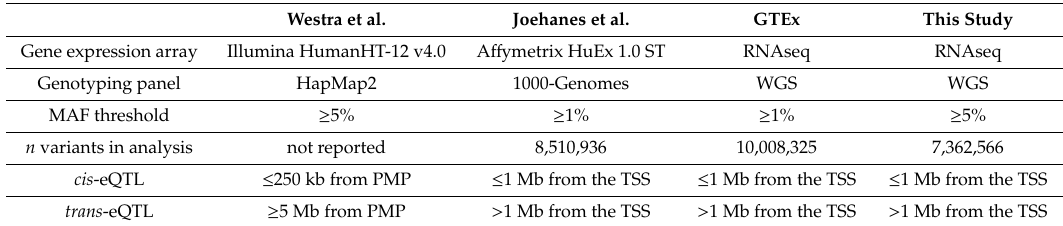
Table 1. Characteristics of the PAH Cohort eQTL mapping study and published eQTL studies used for confirmation. Westra et al. Joehanes et al. GTEx This